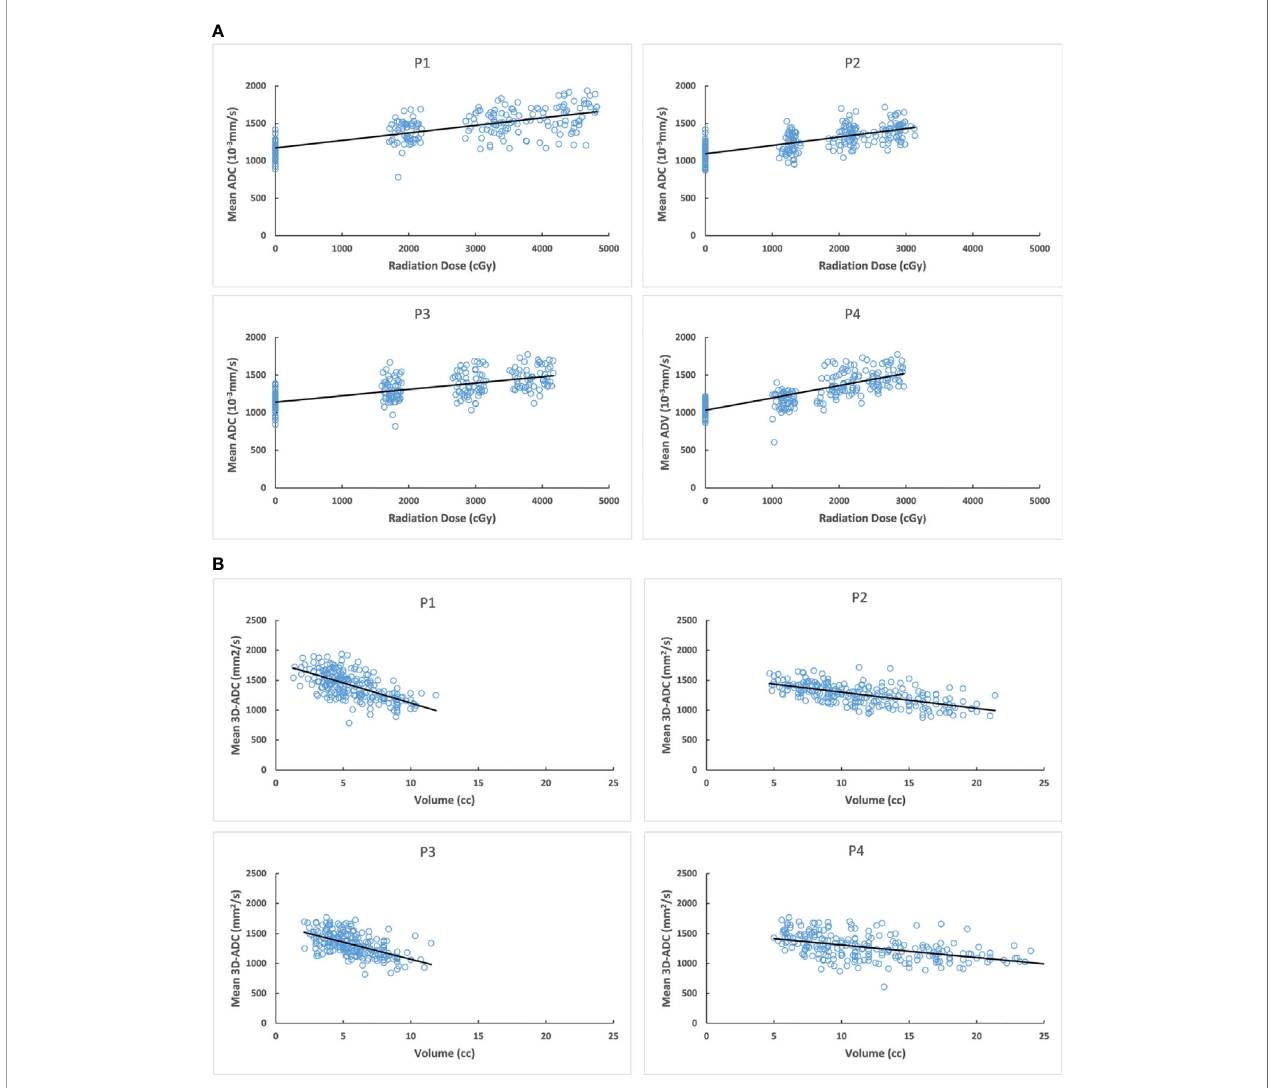
FIGURE 6 | (A) Correlation between mean 3D-ADC changes of different parotid lobes and delivered radiation dose. (B) Correlation between mean 3D-ADC changes of different parotid lobes and volume reduction. P1, deep lobe of ipsilateral; P2, super fi cial lobe of ipsilateral; P3, deep lobe of contralateral; P4, super fi cial lobe of